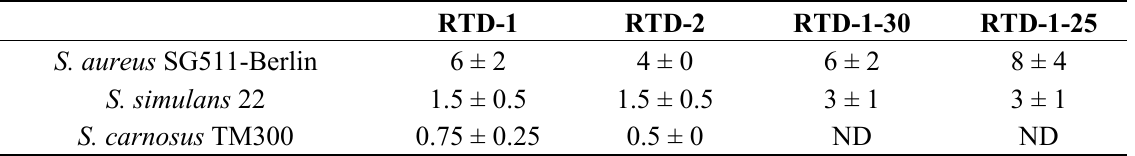
Table 1. Antimicrobial activity of RTDs against staphylococci in half-concentrated MHB. MIC values (µg/mL) * are expressed as the lowest concentration that caused visible growth